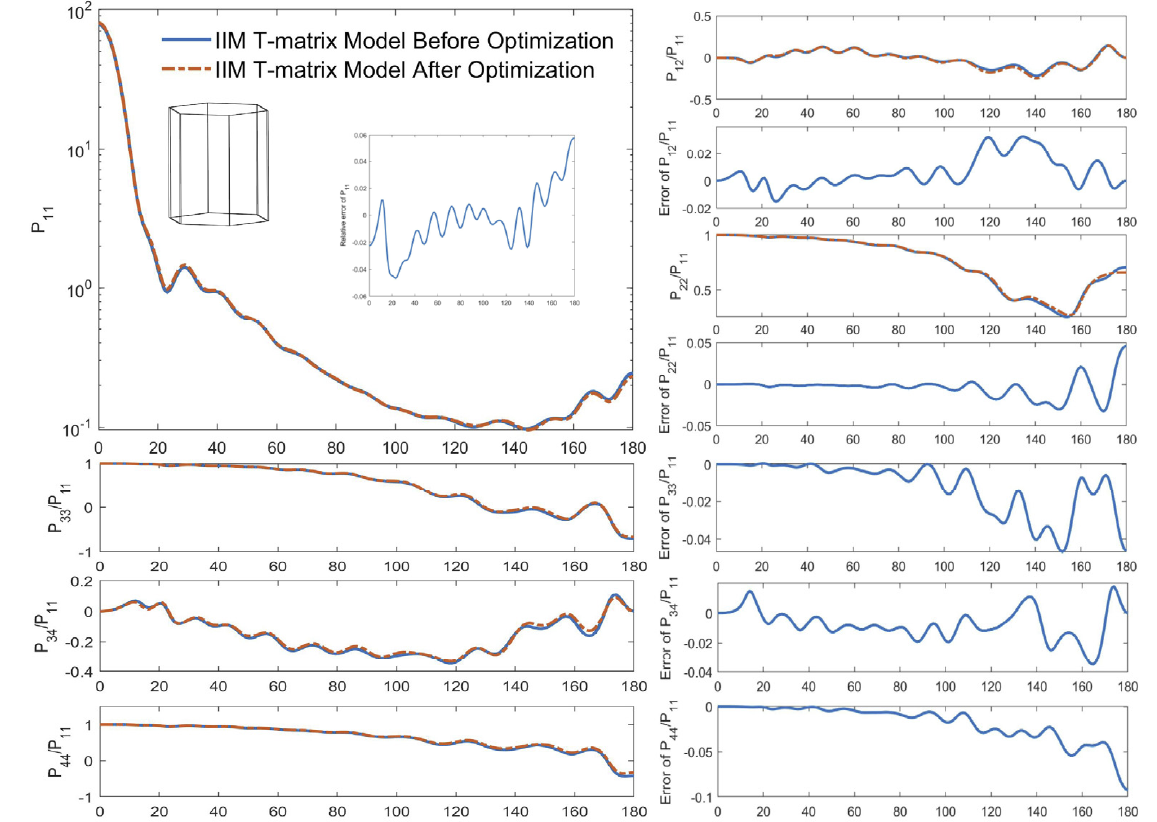
Figure 10. The phase matrices and their errors calculated by the IIM T − matrix models before and after optimization of small hexagonal prism particles with random orientations. The abscissa is the scattering angle. The solid line is the IIM T − matrix model before optimization and the dashed is the IIM T − matrix model after optimization. The errors of P 12 /P 11 , P 22 /P 11 , P 33 /P 11 , P 34 /P 11 and P 44 /P 11 are absolute errors. Table 5. The integral scattering properties of the hexagonal prism particles calculated by IIM T-matrix models before and after optimization.